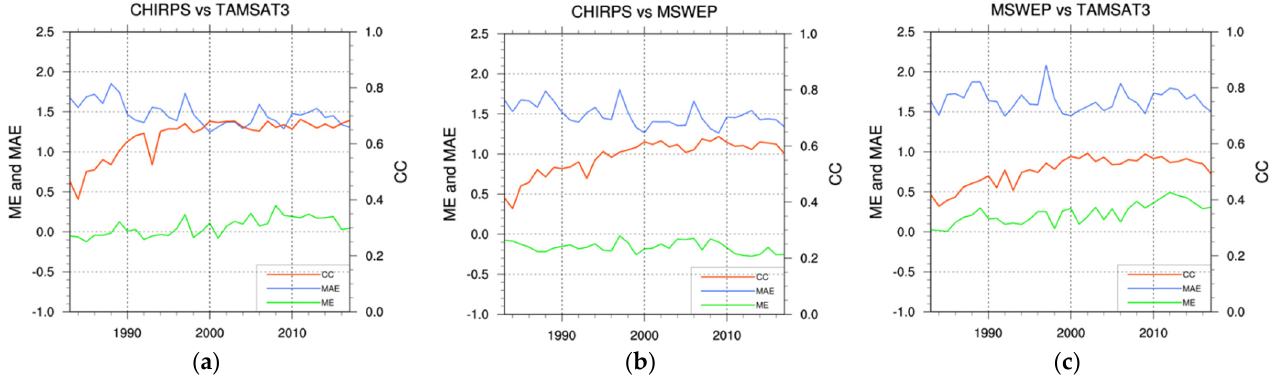
Figure 16. EA-averaged annual ME (mm day –1 ), MAE (mm day –1 ) and CC (right y-axis) for TAMSAT3 with respect to CHIRPS ( a ), MSWEP with respect to CHIRPS ( b ), and TAMSAT3 with respect to MSWEP ( c ).